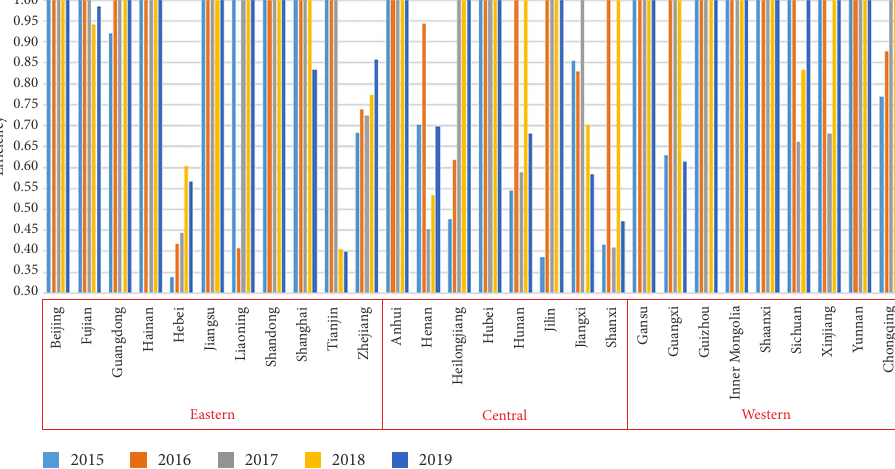
Figure 5. 2015–2019 China’s regional university innovation efficiency